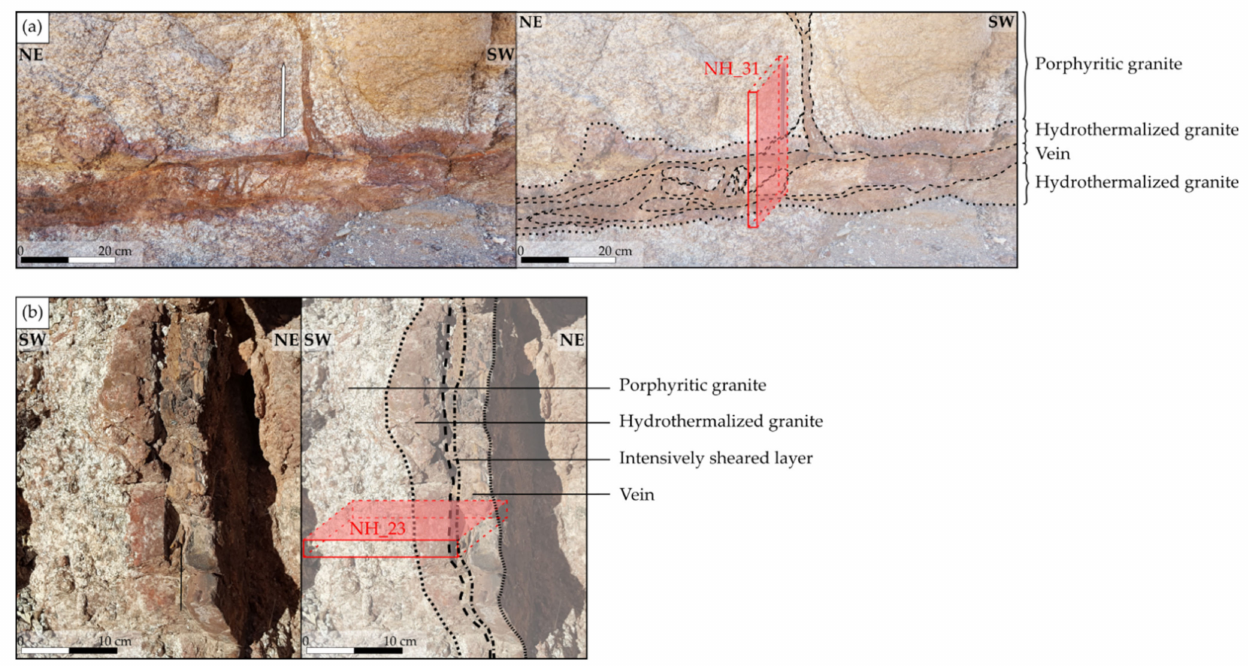
Figure 4. ( a ) Photograph and digitization showing representative hydrothermalized fracture zones observed on the field. ( b ) Photograph and digitization of granite crosscutting by multiple carbonate veins (veins network) altering pervasively the rock.